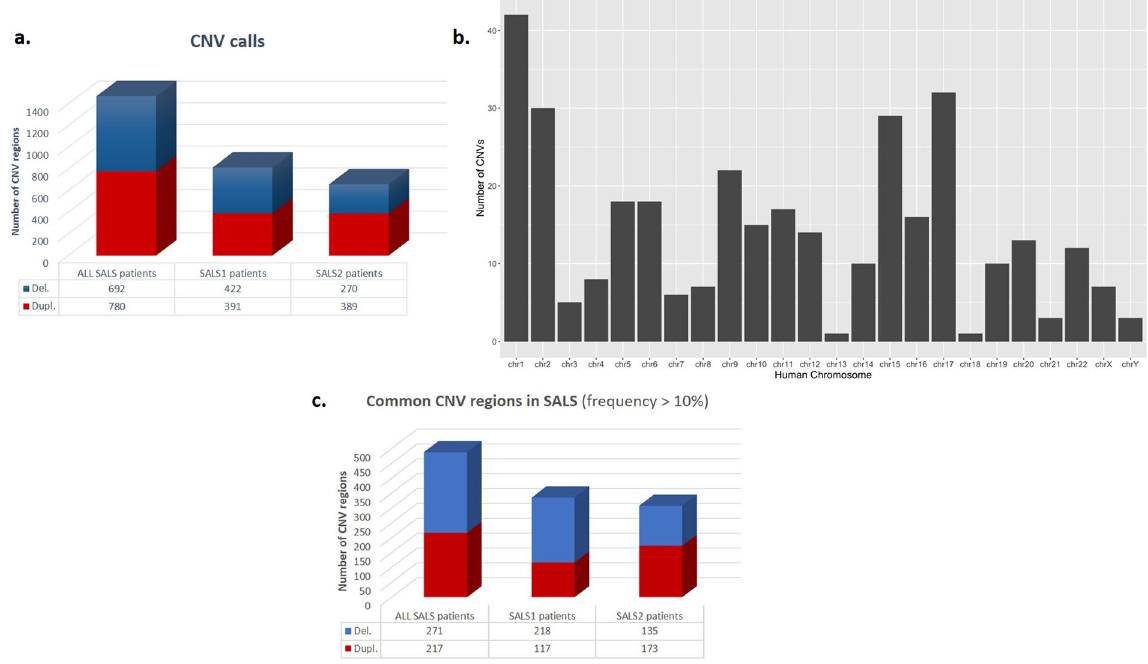
Figure 1. Significant copy number regions in SALS patient subgroups. ( a ) Graphical overview of CNV regions detected in SALS patients by NeuroArray platform. The bars represents the number of regions that may be involved in CNV detected in SALS patients (ADM-2 aberration filter: threshold = 6; Log2 ratio ≥ 0.5 and 3 consecutive interval probes), both with and without the assignment into the hierarchically determined two sets (SALS1 and SALS2). The blue bar represents the number of deleted regions and the red bar represents the number of amplified regions. ( b ) Chromosome distribution of CNVs detected with high-resolution custom exon-centered NeuroArray aCGH from SALS patients. The horizontal axis represents different chromosomes and the vertical axis represents the number of regions of each chromosome that may be involved in CNV. ( c ) Graphical overview of recurrent gains or losses (occurred in at least 10% of the SALS patients), both with and without the assignment into the hierarchically determined two sets (SALS1 and SALS2). The blue bar represents the number of deleted regions and the red bar represents the number of amplified regions that occurred at a high frequency ( ≥ 10%) in our cohort of SALS